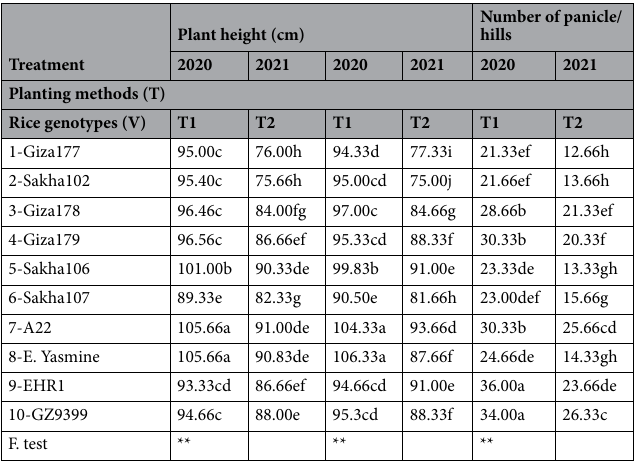
Table 12. Plant height and number of panicle/hills affected by the interaction between the studied actors. T1 = Transplanting, T2 = Aerobic, **Significant at 0.01 level. Means followed by a common letter at the same column are not significantly different according to Duncan ’ s multiple range at 0.05 levels.